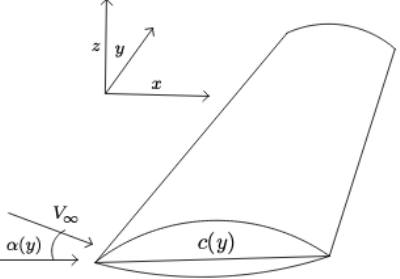
Figure 1. Airfoil, freestream and coordinate system.